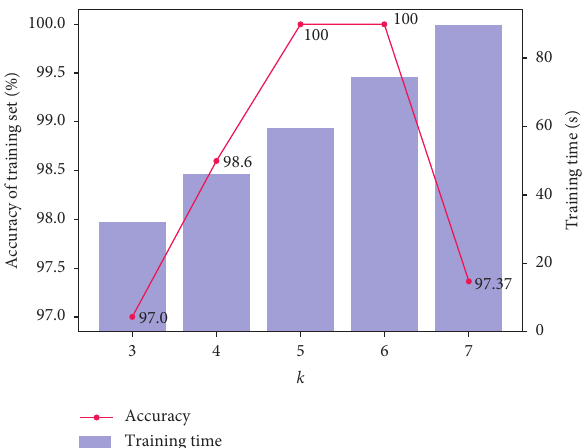
Figure 15: The influence of k on training time and diagnosis accuracy of the model.